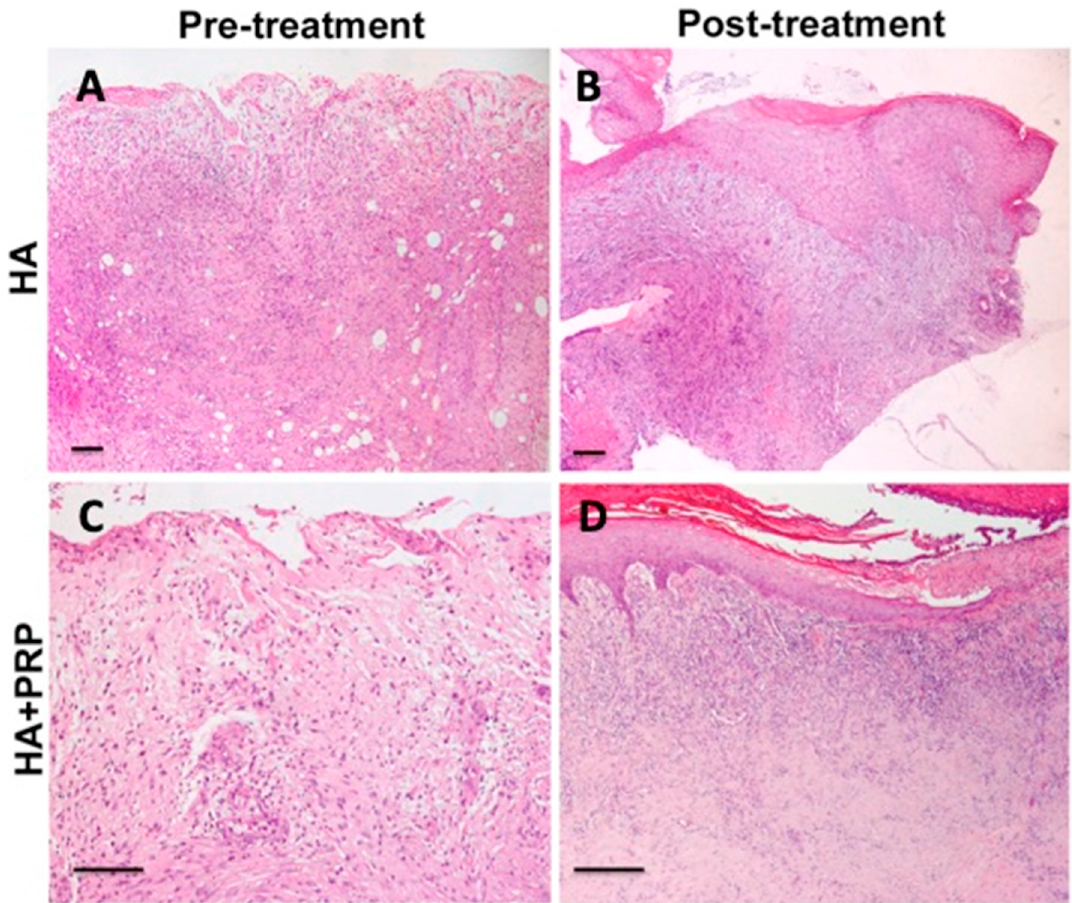
Figure 10. Representative microscopic images of haematoxylin & eosin-stained paraffin sections of skin biopsies at baseline. ( A ) and ( C ) Pre-treatment biopsies showed cellular debris and dermal inflammatory infiltrate; ( B ) and ( D ) Post-treatment images showed ulcer healing with re-epithelialization and new formed dermal tissue (magnification 4×). Scale bar ( A – D ), 100 µm.